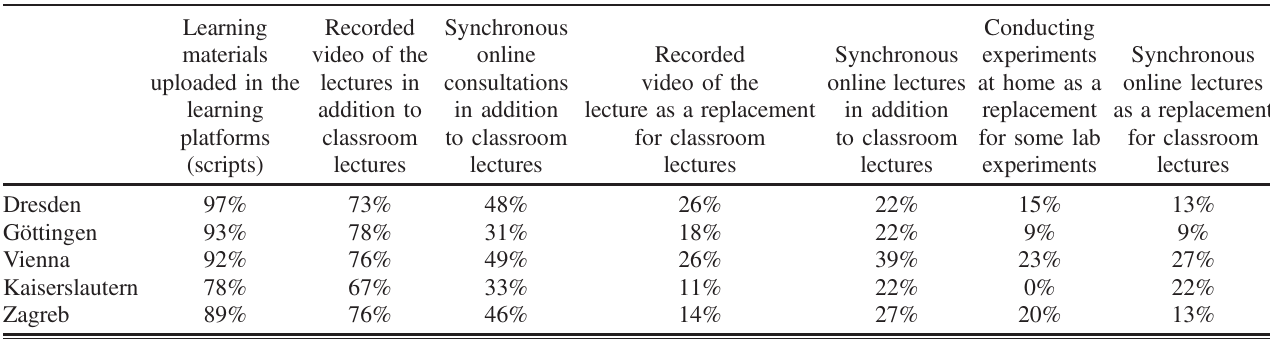
TABLE XII. Elements that students want to preserve in the future — results from